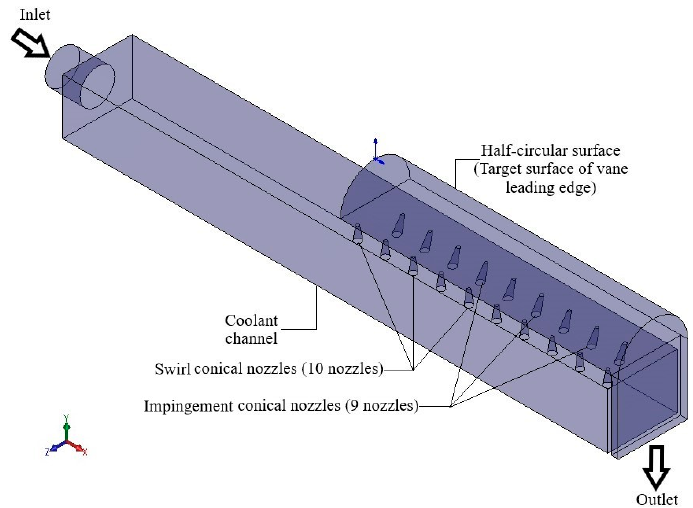
Figure 1. 3D structure of the compound cooling unit.